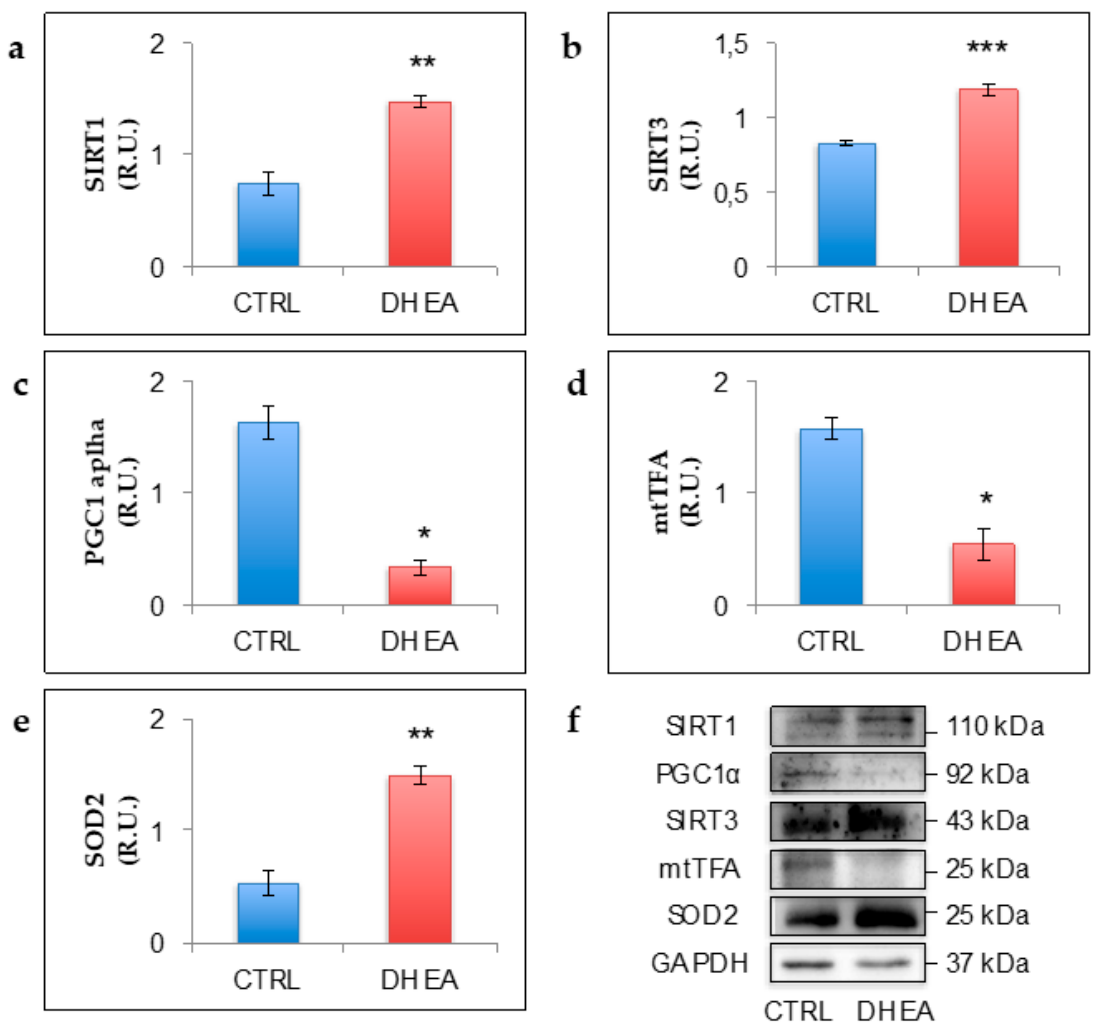
Figure 6. Western blot analysis of Sirtuin 1 (SIRT1) ( a ), SIRT3 ( b ), peroxisome Figure 6